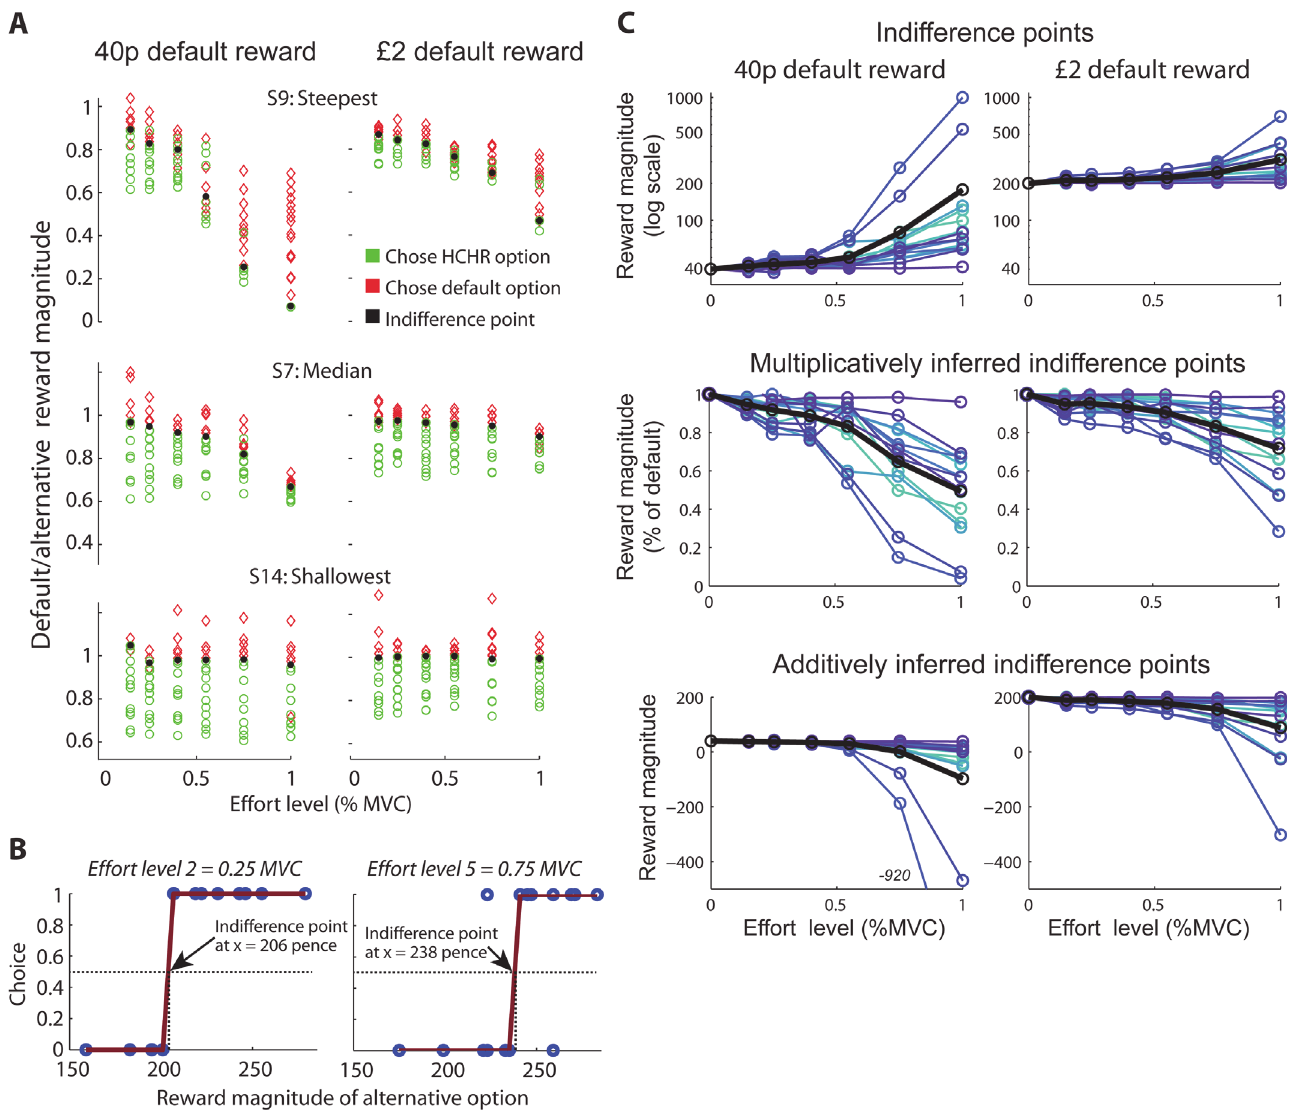
Fig 4. Experiment 2: Model-free analysis of effort discounting. A , Offered stimuli and choices from Experiment 2 are shown for the participants with the steepest, median and shallowest discounting, respectively, separately for the block with a default reward magnitude of 40p (left) and £2 (right). Stimuli were dynamically adjusted using a hidden staircase procedure to identify individual participant ’ s indifference points. For each effort level, the offered reward magnitude is displayed as the default option divided by the alternative option, thus yielding values < 1 when the alternative option was associated with more reward (for alternative representations of indifference points, see panel C ). Choices of the higher-reward/higher-cost option are indicated in green, choices of the effortless default option in red, and inferred multiplicative indifference points in black. B, Procedure for determining indifference points: A sigmoid function was fitted separately to the choices generated at each effort level (y axis: 0 = default option chosen, 1 = alternative option chosen), given the reward magnitude of the alternative option (x axis). The point of subjective indifference between the default and the alternative option was defined as the reward magnitude at which where the sigmoid crossed y = 0.5. Exemplary choices and fits are shown for one subject and two effort levels in the £2 (200p) block. C , Individual (coloured) and average (black) group indifference points show that effort discounting follows a concave, rather than convex, shape and scales with offer magnitude (40p vs. £2). Shown are the raw untransformed indifference magnitudes (top), a multiplicative representation of indifference points, i.e. default magnitude / indifferent magnitude (middle), and an additive representation of indifference points, i.e. (default magnitude — (indifferent magnitude — default magnitude)) (bottom). A multiplicative representation yields a percentage decrease, whereas an additive representation reflects the absolute decrease in value, which can easily lead to negative values. These data do not depend on any model fits and in all cases clearly reflect the concave nature of effort discounting, the main message of this